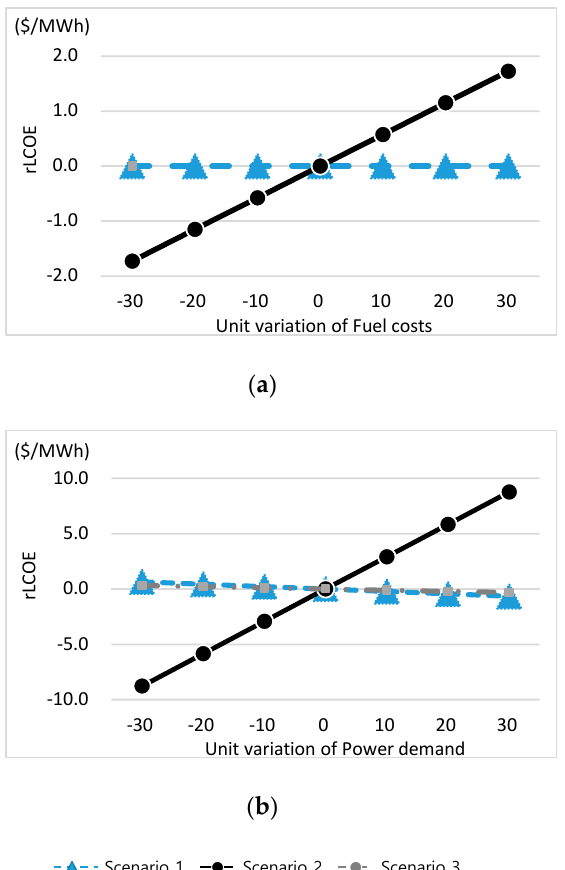
Figure 8. Sensitivity analysis. ( a ) Generation costs with variable fuel costs. ( b ) Generation costs with variable demand.